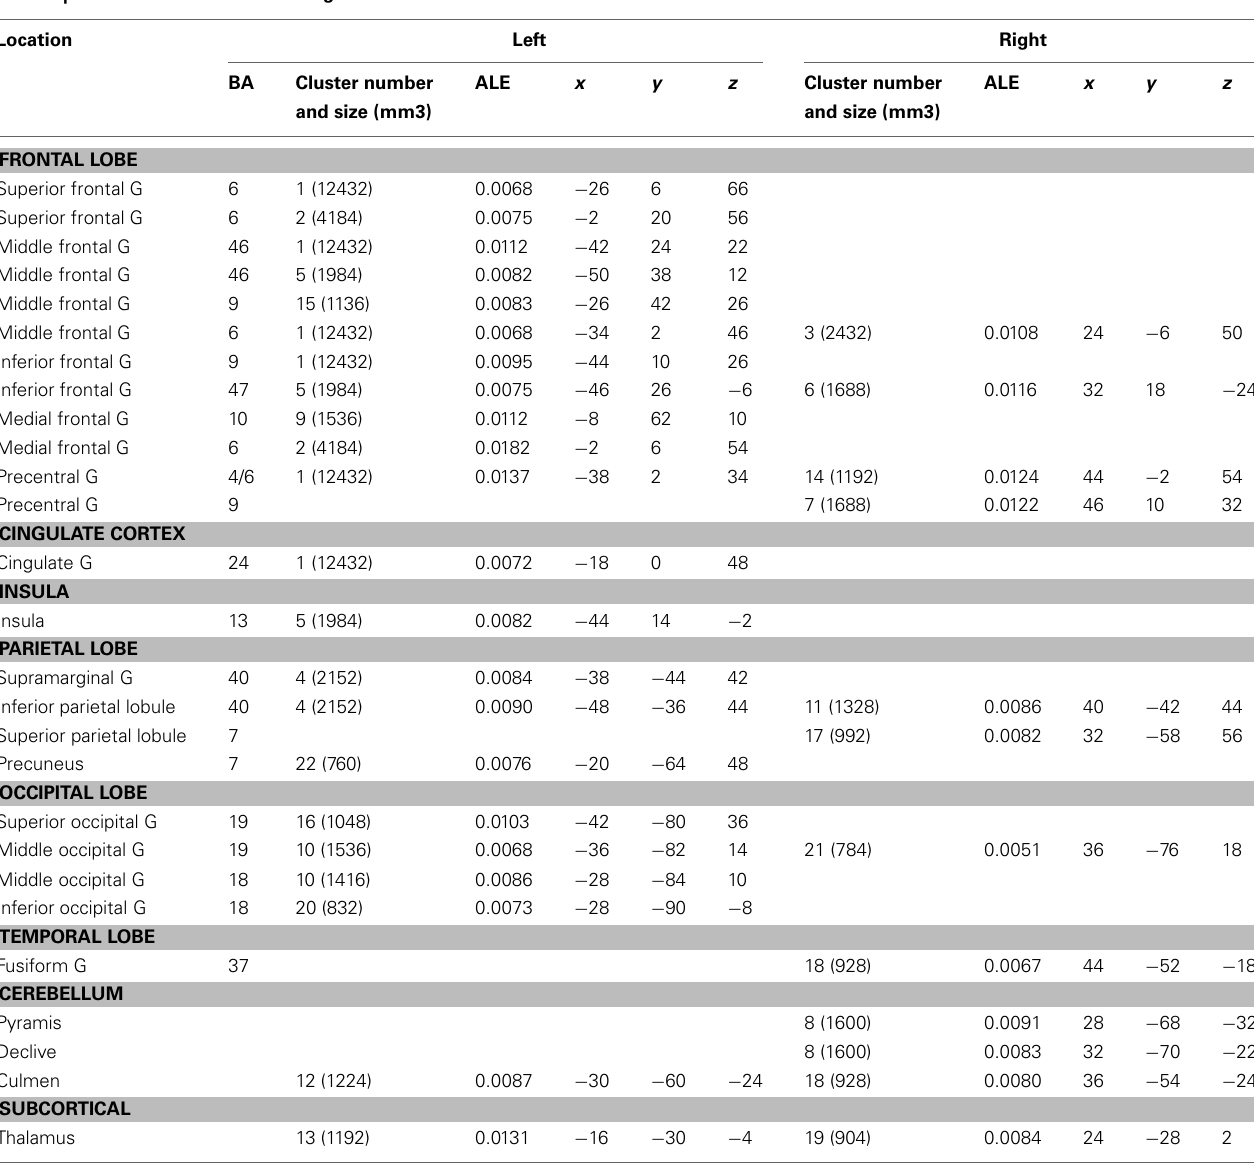
Table 7 | Locations of clusters with significant ALE values for non-verbal